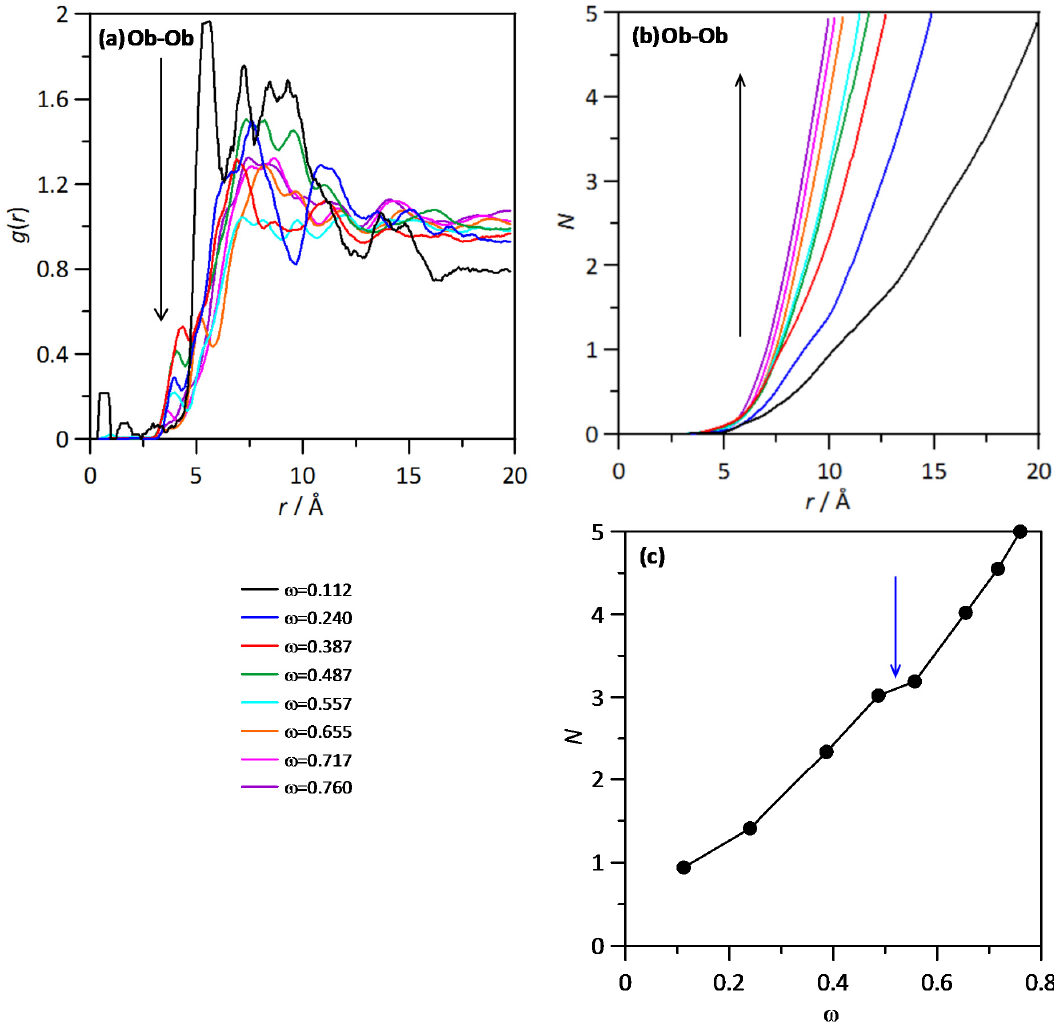
Figure 10. ( a ) Site-site radial distribution functions, g ( r ), and ( b ) running integrals, N , for the reported atomic pairs in ω THAL + (1- ω ) water mixture at 310 K. The arrows indicate increasing ω . Atom labelling as in Figure 1. Results in panel ( c ) show N for r < 10 Å as a function of mixture composition.